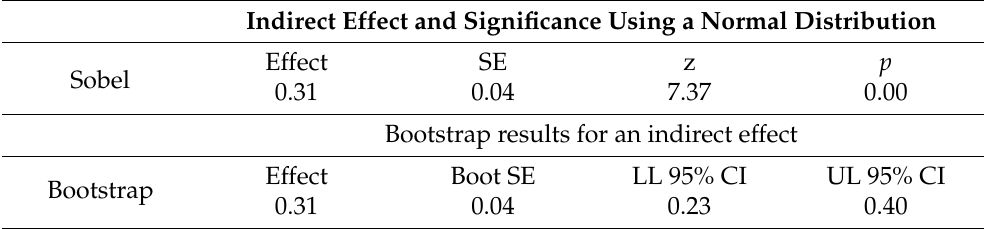
Table 3. Indirect Effect of Performance Climate on Knowledge Hiding (T2) Through Work Alienation.